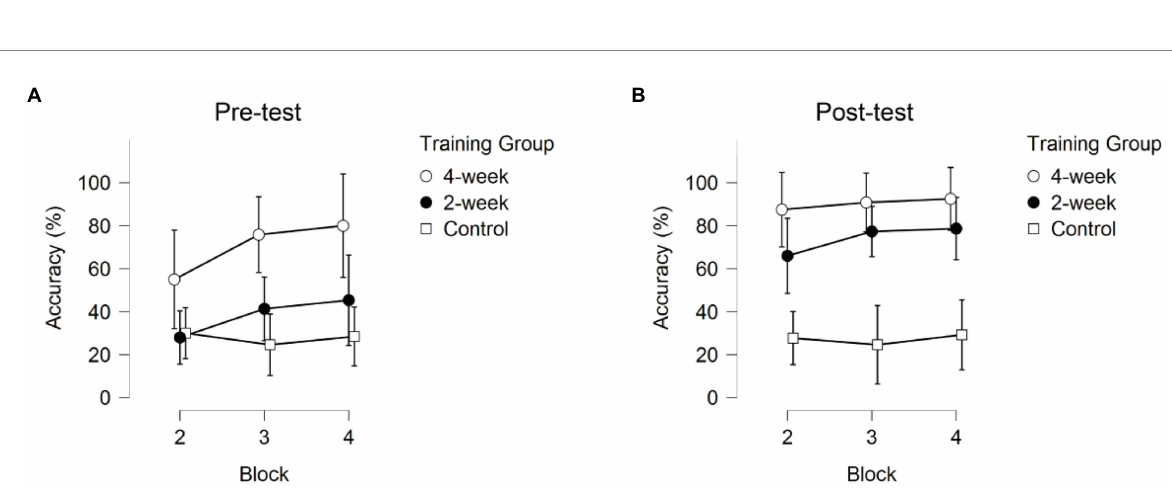
FIGURE 3 The Response Accuracy across the three blocks for the pre-test and post-test sessions. Error bars represent 95% CIs between groups. (A) after the term “pre-test” and (B) after